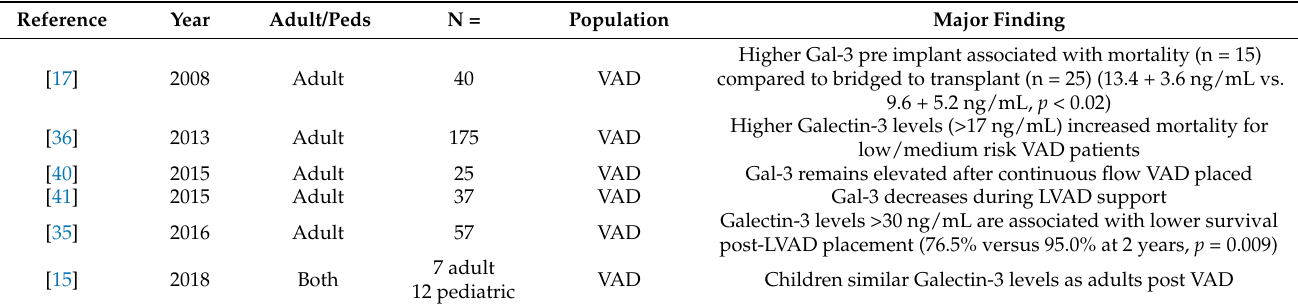
Table 2. Application of galectin-3 in adult and pediatric patients with heart failure requiring ECLS.